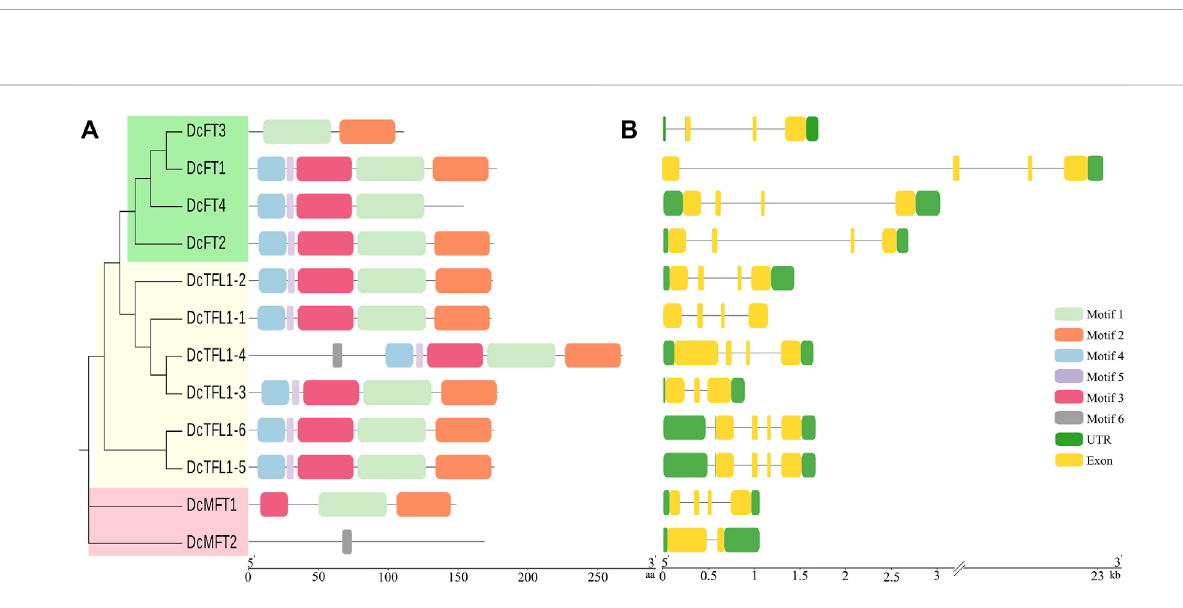
FIGURE 3 Gene motifs and structures of 12 PEBP genes in carrot. Boxes with different colors indicate conserved motifs, and the lengths of motifs in each protein are shown proportionally (A) . UTRs and exons are represented by green and yellow boxes respectively (B)